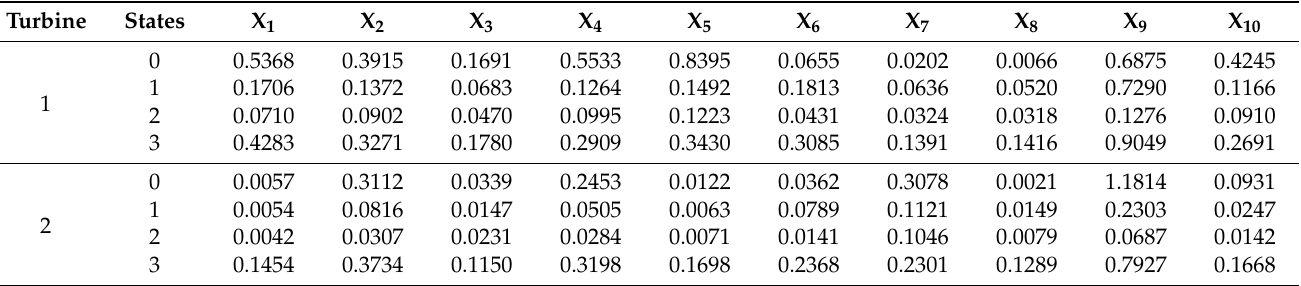
Table 7. The cross-section data of the integrated importance measure under states 0, 1, 2, and